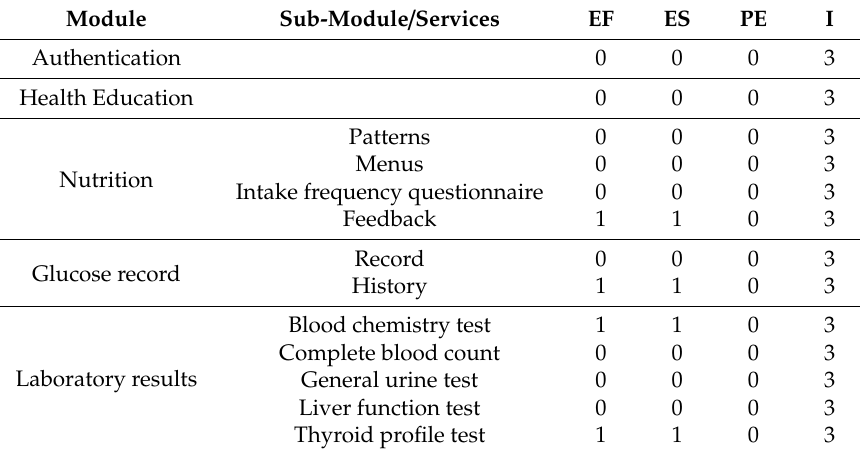
Table 3. Test of the services of the web application for patients. (EF) errors found, (ES) errors solved, (PE) pending errors, and (I) iterations.